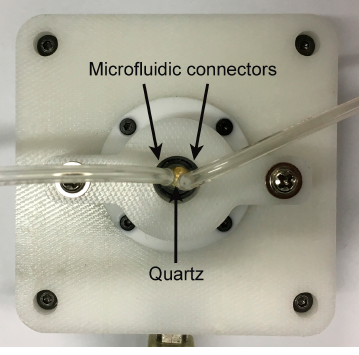
Figure 4. Flow cell of the QCM device manufactured by Novaetech s.r.l.